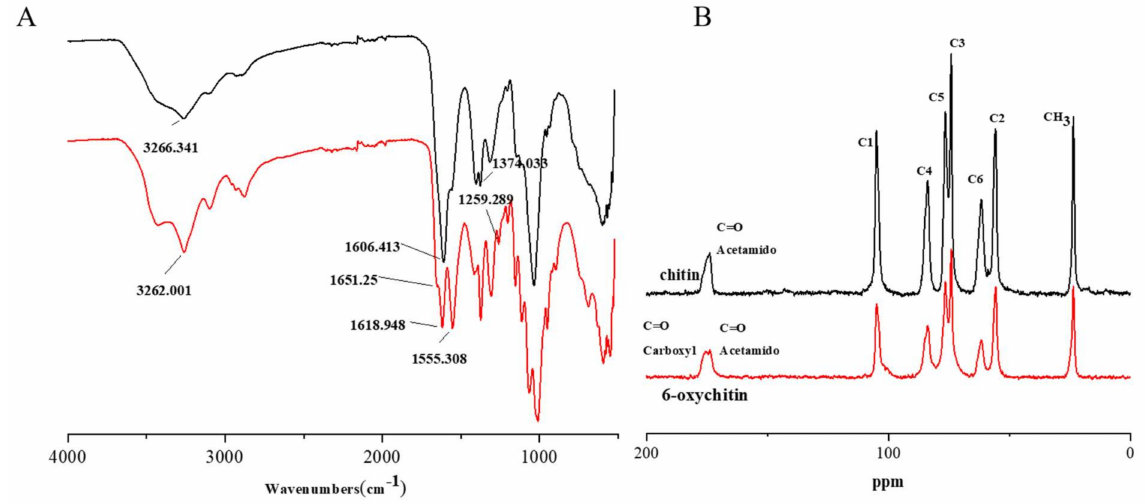
Figure 1. The FT—IR ( A ) and 13 C NMR ( B ) spectra of chitin and oxidized